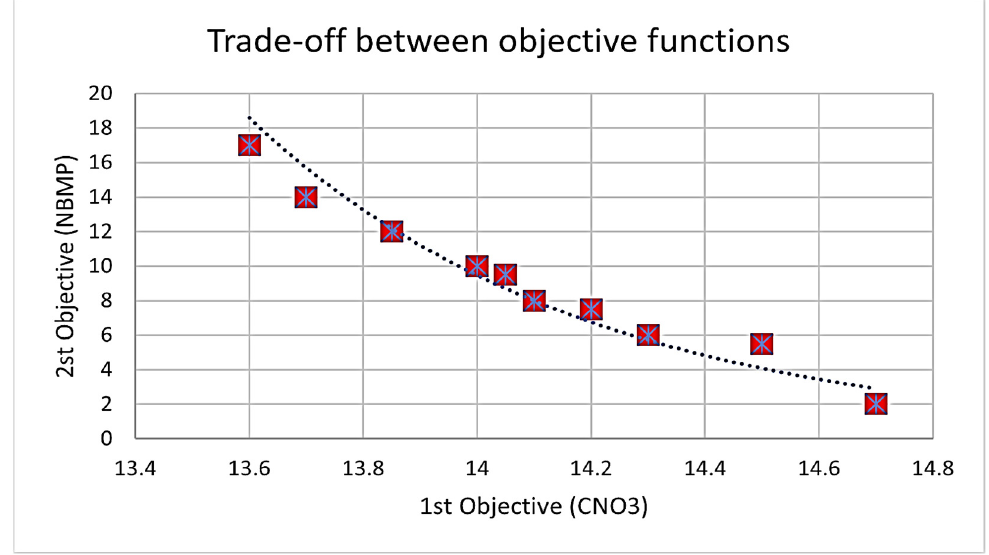
Figure 7. The trade-off between the objective functions represents the percent improvement in the water quality objective function on the Pareto front considering BMPs in the watershed. Table 9. The information extracted from MOPSO.